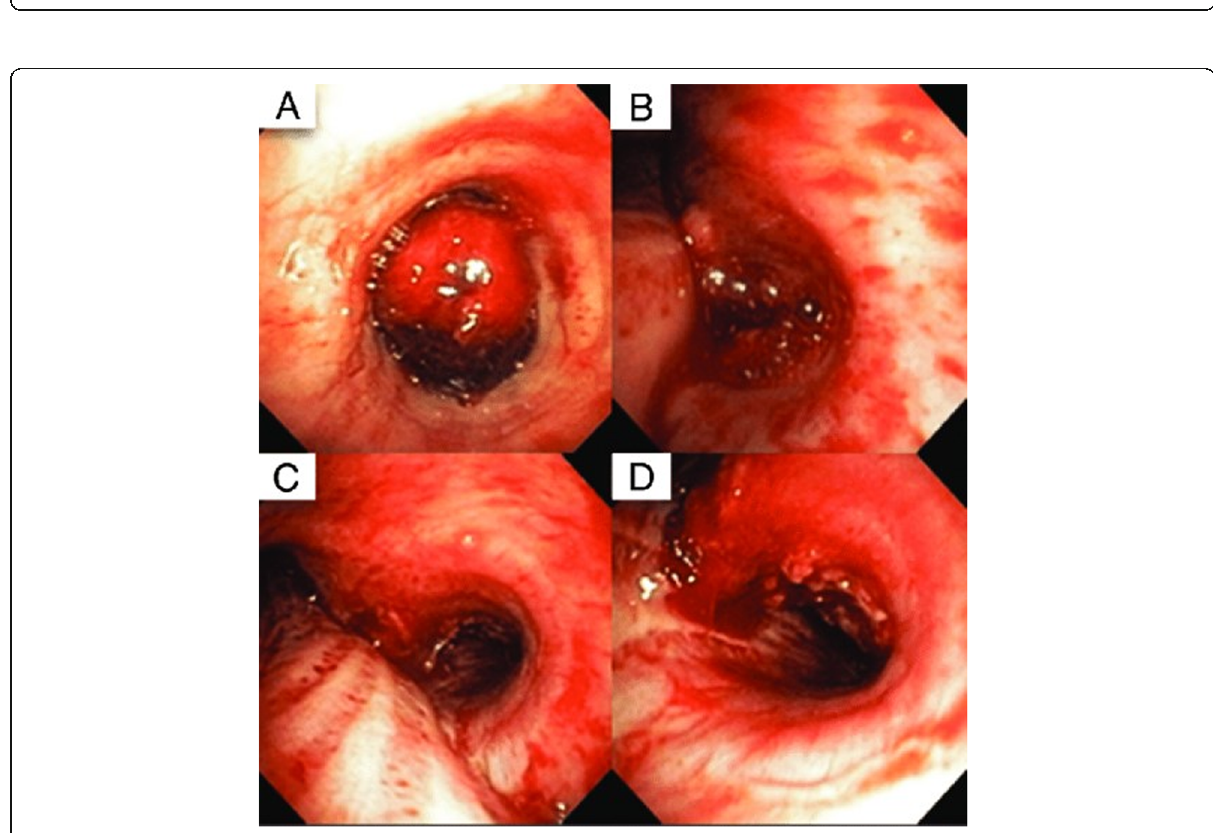
Fig. 2 a Pre-debulking rigid bronchoscopy showing polypoidal obstructing growth, just proximal to the carina. b – d Post-debulking bronchoscopy showing residual tracheal tumor with normal distal tracheobronchial